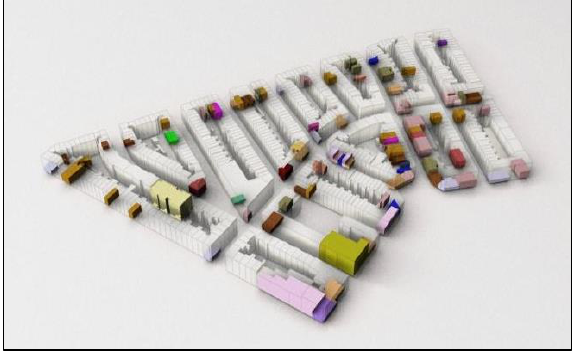
Figure 4. Example of indoor space calculation in Fannius Scholtenbuurt, Amsterdam. Transparent volumes: LoD1 buildings, coloured volumes: non-residential spaces (the colour coding corresponds to the type of space).